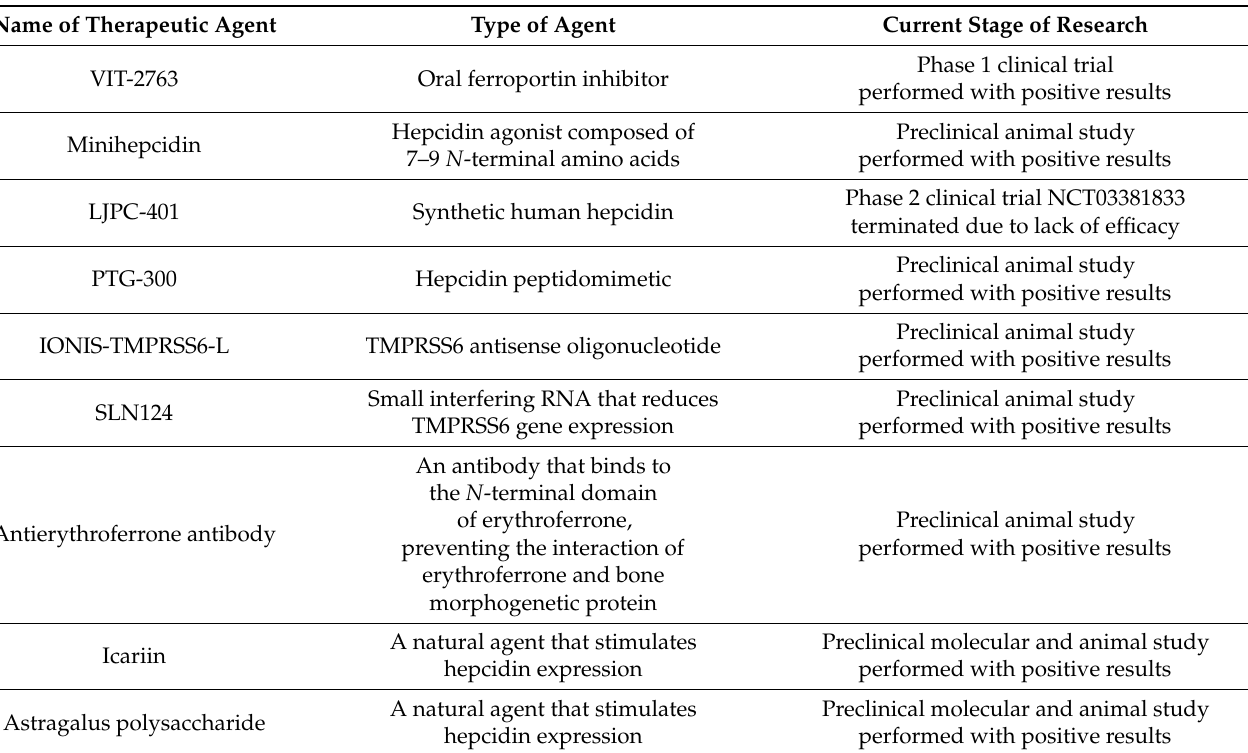
Table 2. Summary of theoretical